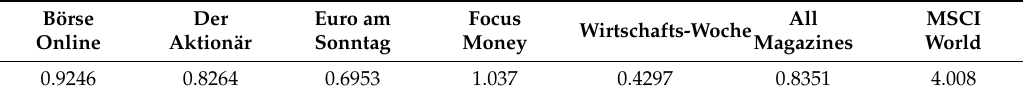
Table 2. Sharpe ratios of magazines and MSCI World